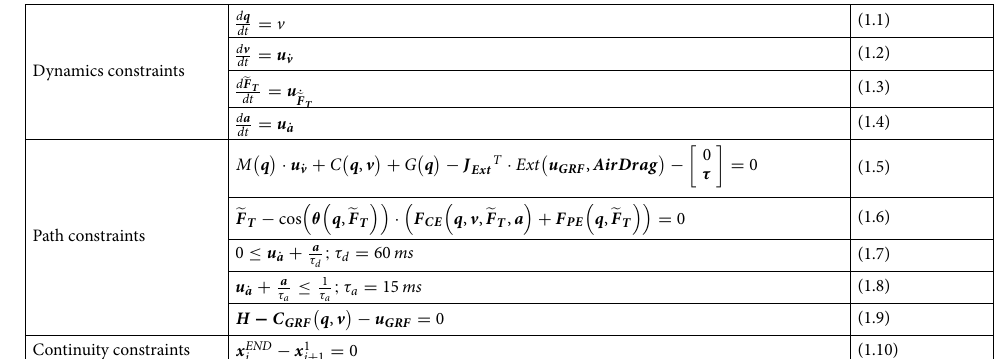
Dynamics constraints